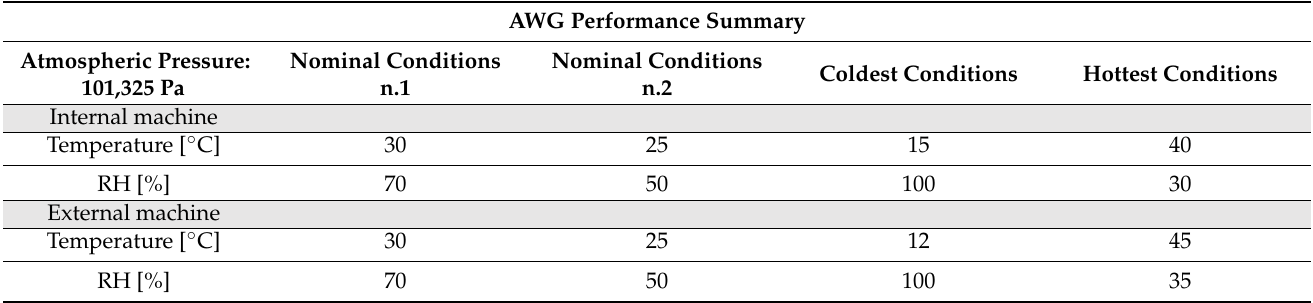
Table 4. Proposed normalised